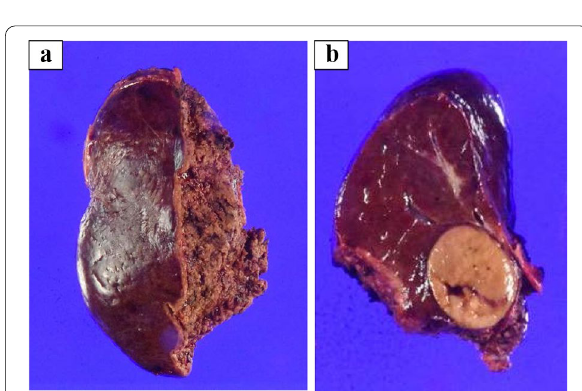
Fig. 4 Macroscopic findings. a Resection specimen of the hepatic segment 5 6 subsegmental. b Cross section of the tumor. The + tumor was 2.6 2.1 1.8 cm in size with a capsule and a well-defined × × white